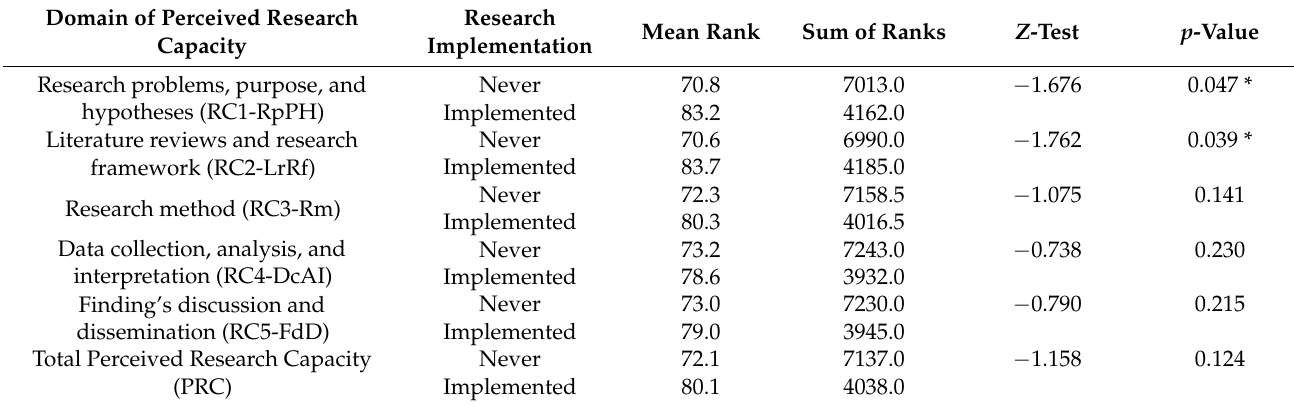
Table 4. Association between PRC and research implementation.